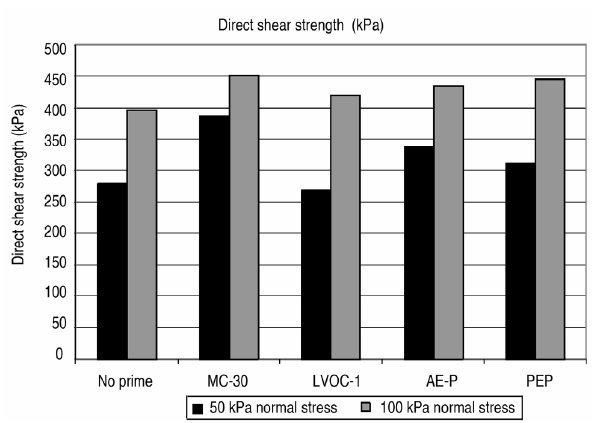
Fig 1 . Direct shear strength for various prime coat